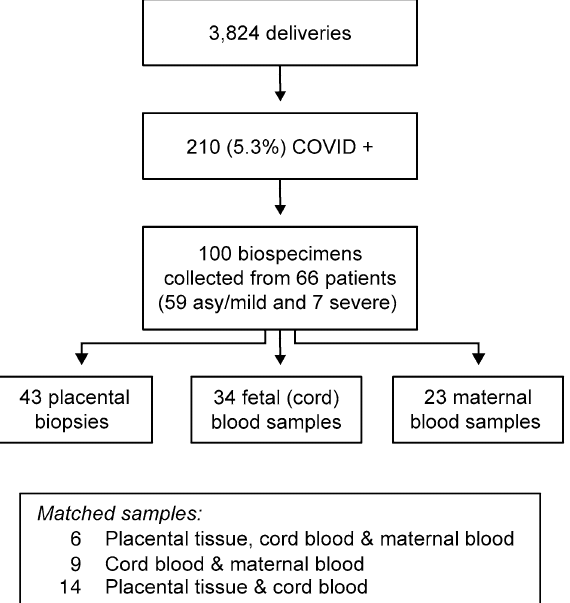
Figure 1. Study participants and specimens collected for the study. See text for details. Matched maternal- placental-fetal samples were collected from a small fraction of the